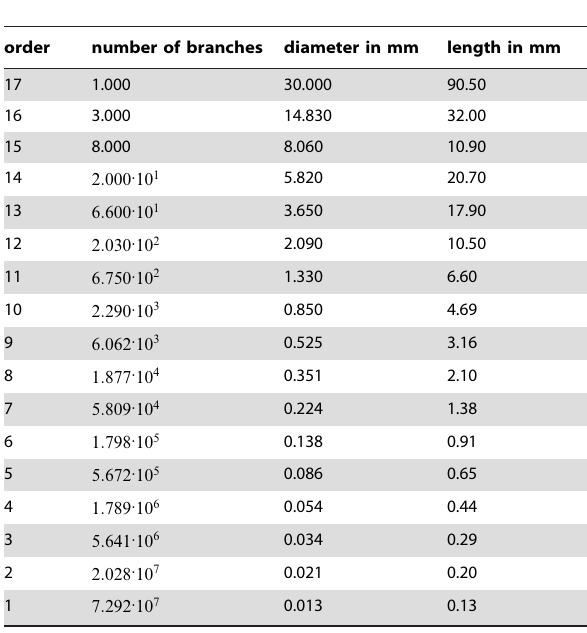
precondition that the Strahler ordering system can be used for the classification of pulmonary vessels is the dichotomous branching of the pulmonary vascular tree [25].